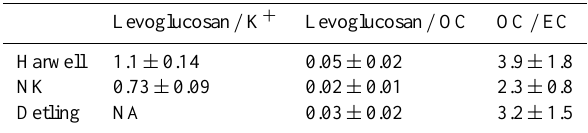
Table 6. Average of daily results for selected ratios. Variability shown is 1 standard deviation. Note NA means not